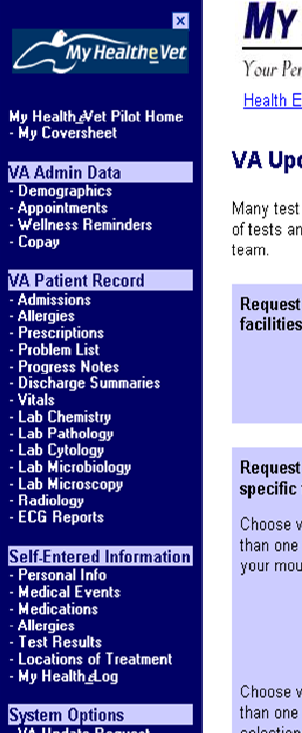
Figure 1. My Health e Vet Pilot landing page